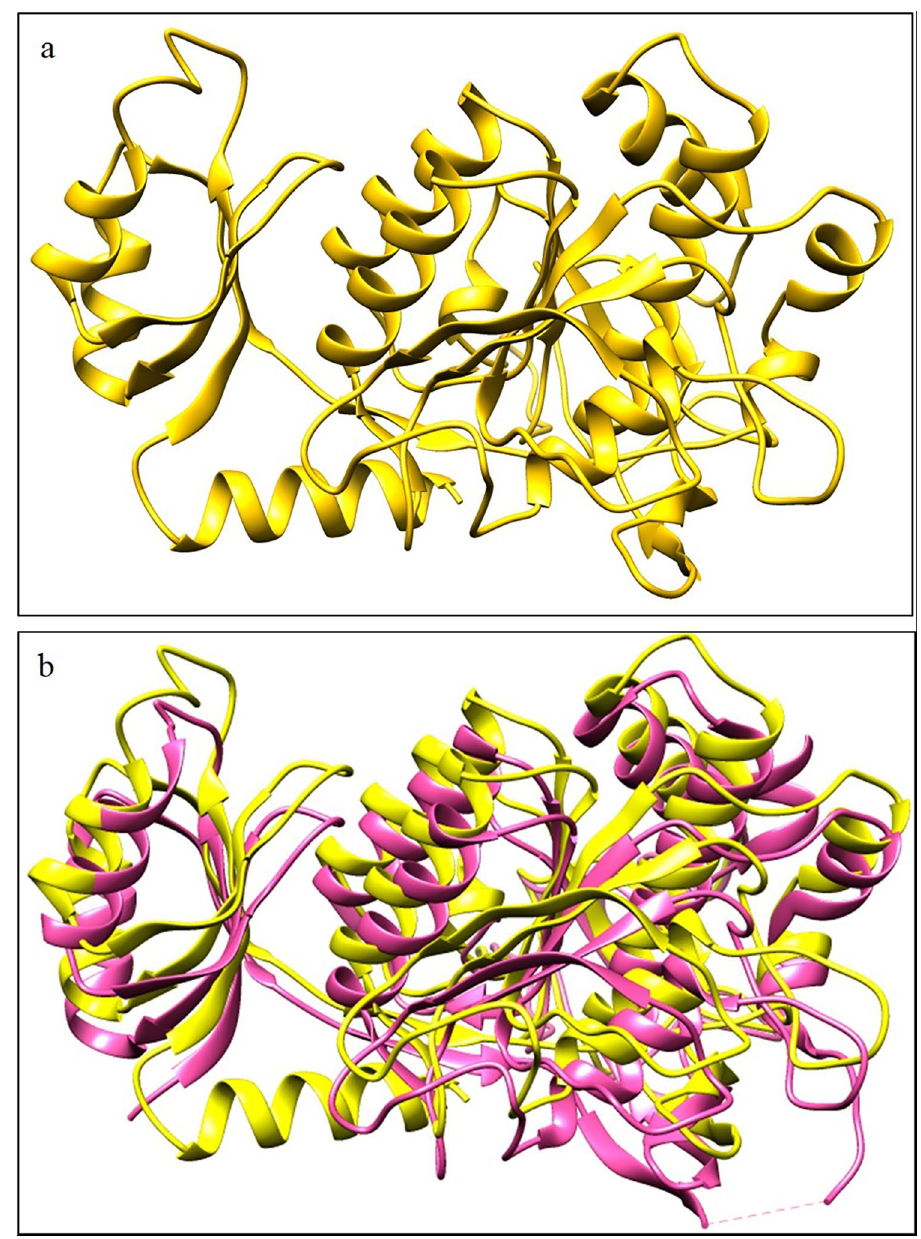
Figure 5. ( a ) UCSF Chimera rendered a refined model of alkaline cold-active protease (Apr-BO1). Model generation was done by GalaxyTBM and among the five predicted models the best one was refined by GalaxyRefine. ( b ) Superimposed structures of Apr-BO1 model (yellow colour) and template (PDB ID: 3WHI) in hot pink. This ID corresponds to subtilisin E of Bacillus subtilis . Root mean square deviation (RMSD) was calculated between template and model using the Chimera tool, and it was observed that RMSD between 323 pruned atom pairs is 0.372 Å. RMSD is a quantitative estimate of similarity between two protein structures. Lower the value of model-template RMSD better is the model